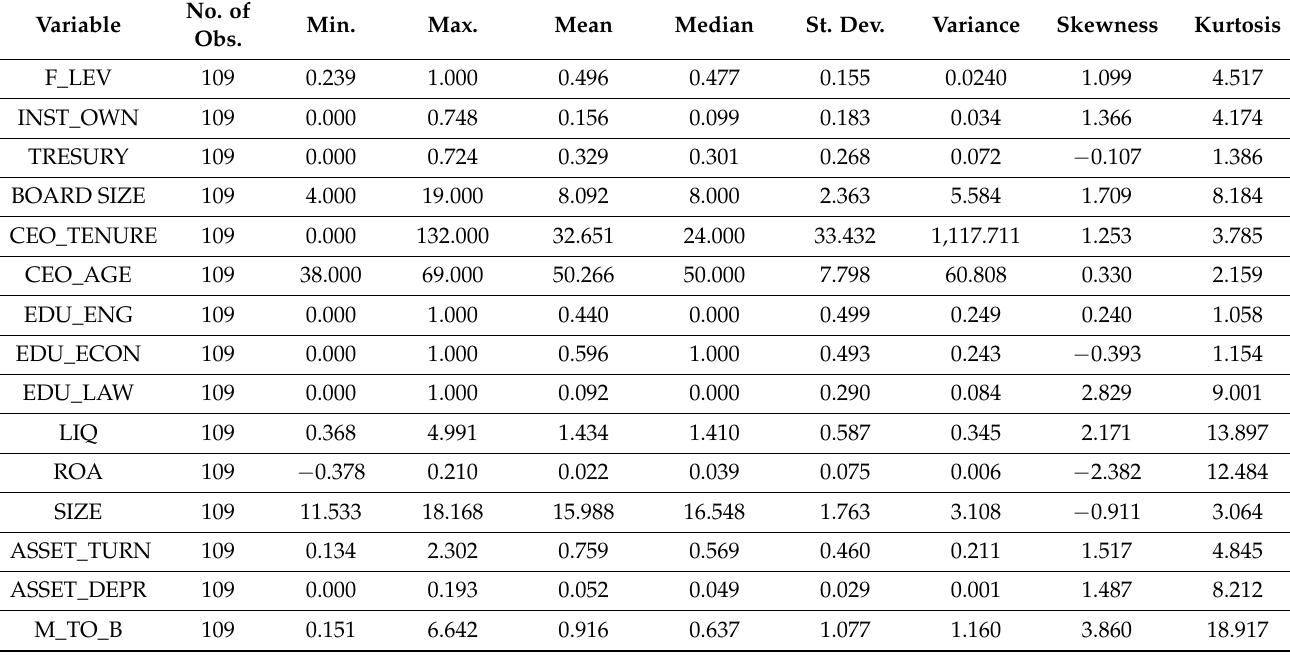
Table 2. Descriptive